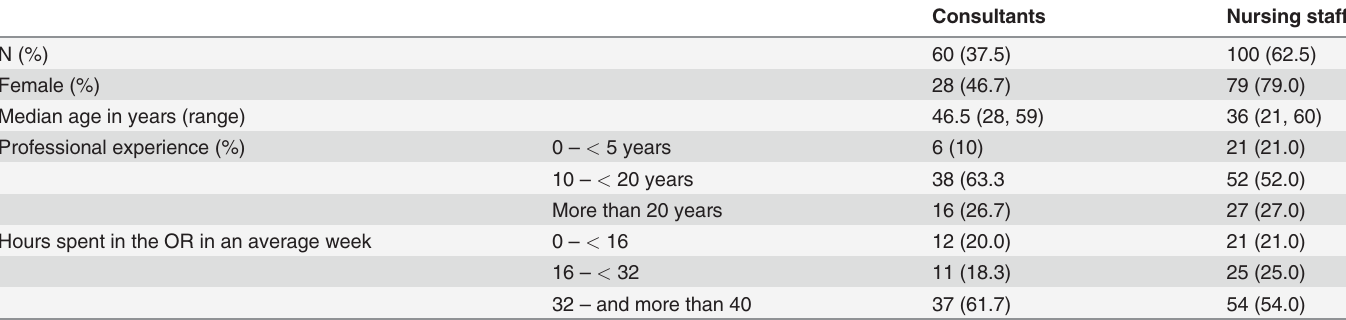
Table 3. Online survey – sample characteristics.